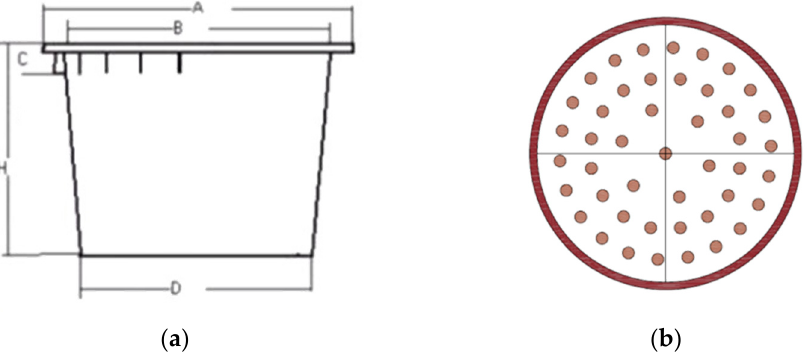
Figure 3. Scheme of the dimensional parameters of pots used in the three trial years ( a ); scheme of the corm sowing in 2015 ( b ).